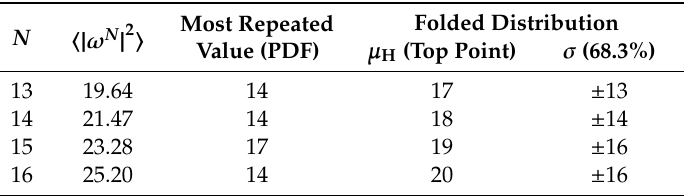
Table A14. Statistical parameters of SAW size for the SC restricted lattice as a function of SAW steps (fixed: n = 5, Type 3) for selected systems.